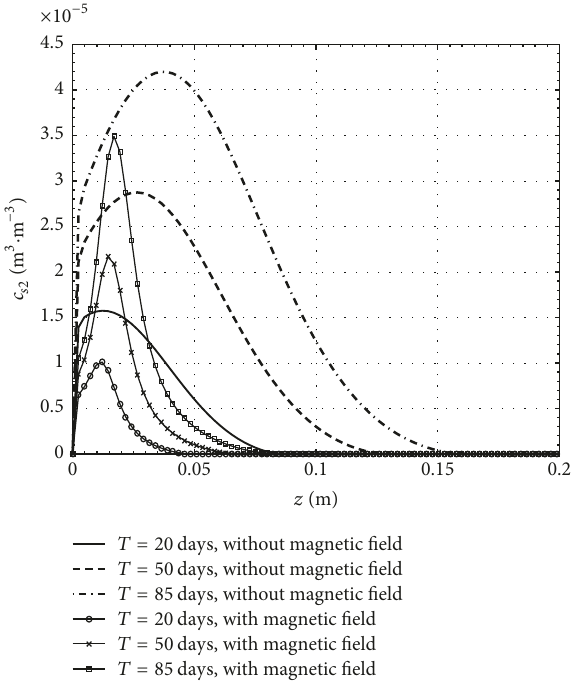
Figure 13: Pore throat deposited nanoparticles concentration against core distance with and without magnetic field effect for various values of imbibition time: magnet is placed on the left side of the